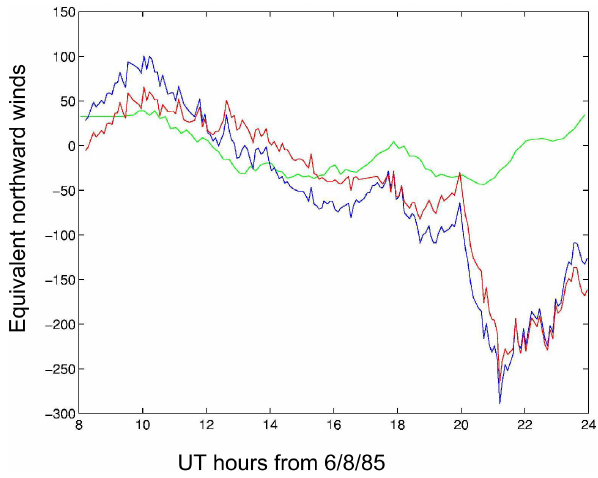
Fig. 3. This figure demonstrates the uncorrected (red line) and cor- rected winds (blue line) from one day of an EISCAT experiment on 6 August 1985, together with the electric field correction (green line) which has been applied (all in